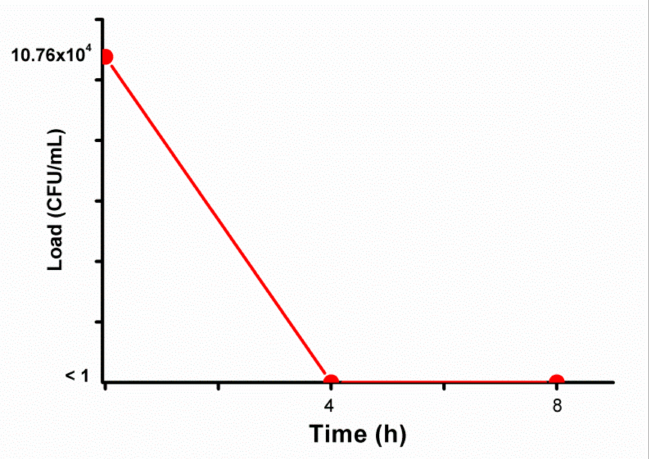
Figure 3. Microbial load after electrocoagulation (EC) experiments using electrodes of steel swarf (SfE).